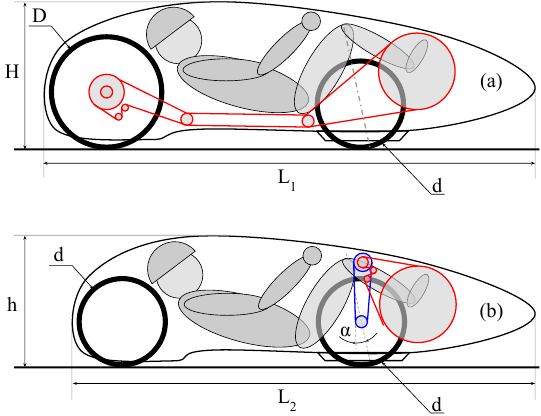
Figure 1. Most common ( a ) rear wheel drive (RWD); and ( b ) front wheel drive (FWD) layouts for Human Powered Vehicle (HPV) transmission.